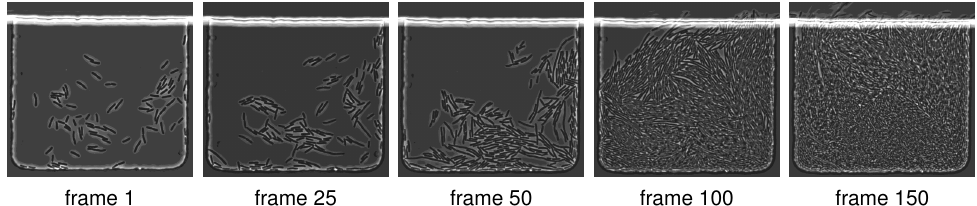
Figure 1. Typical microscopy image sequence. We show five frames out of a total of 150 frames of an image sequence showing the dynamics of E. coli in a microfluidic device [18] (real laboratory image data). These cells are are about 1 µ m in diameter and on average 3 µ m in length, and they divide about every 30 min. The original images exported from the microscope are 0.11 µ m/pixel. We report results for these real datasets in Section